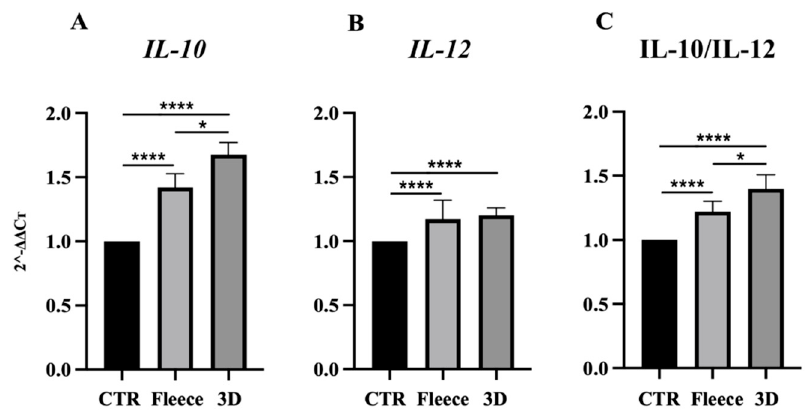
Figure 7. Gene expression profile of ( A ) anti-inflammatory IL-10 and ( B ) pro-inflammatory IL-12 cytokines in CTR and AECs seeded on fleeces and on 3D scaffolds after 48 h of culture. AECs after 48 h of culture on Petri dishes was used as the CTR (AECs at 48 h = 1). ( C ) IL-10/IL-12 ratio of the expression levels in CTR and in AECs seeded on fleeces and 3D scaffolds after 48 h. * and **** Statistically significant values between the different studied groups ( p < 0.05 and p < 0.0001, respectively).